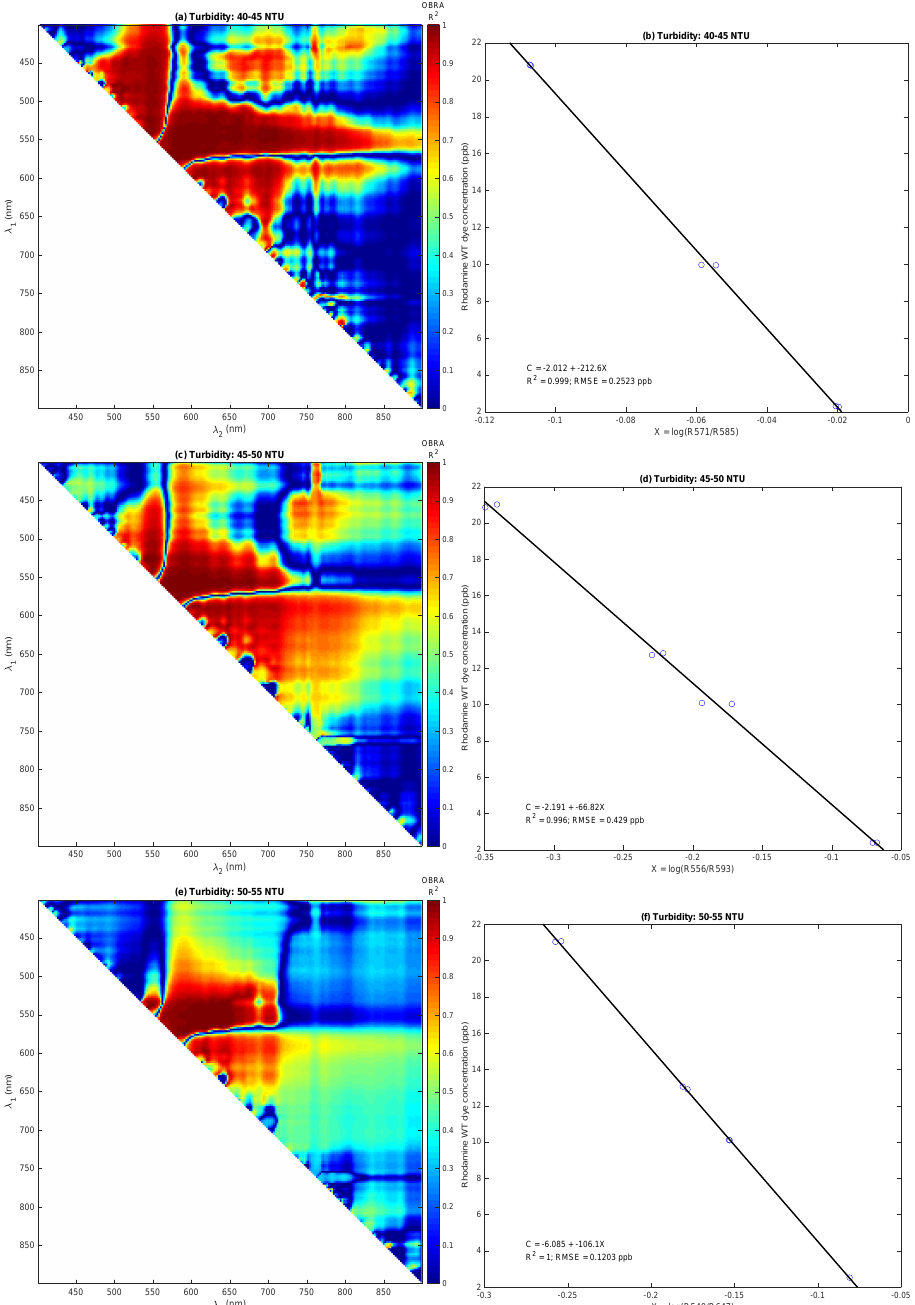
Figure 5. OBRA of small Unoccupied Aircraft System (sUAS)-based Nano hyperspectral images stratified by turbidity